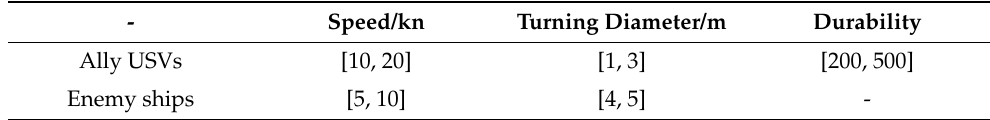
Table 1. Capability settings in the defense